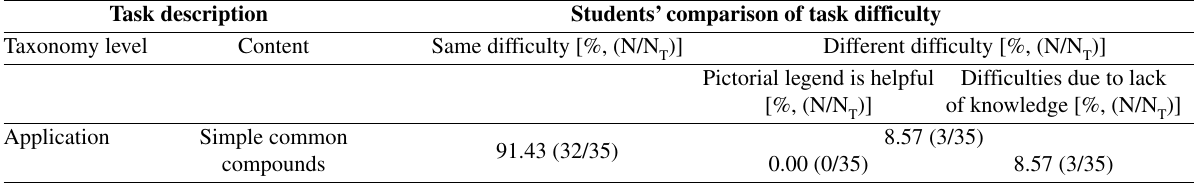
Table 7. Analysis of students’opinion about solving tasks in Section 2 Task description